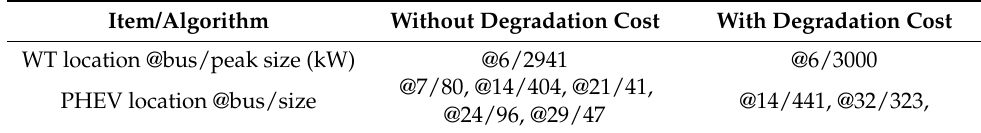
Table 6. The optimal solution without and with battery degradation